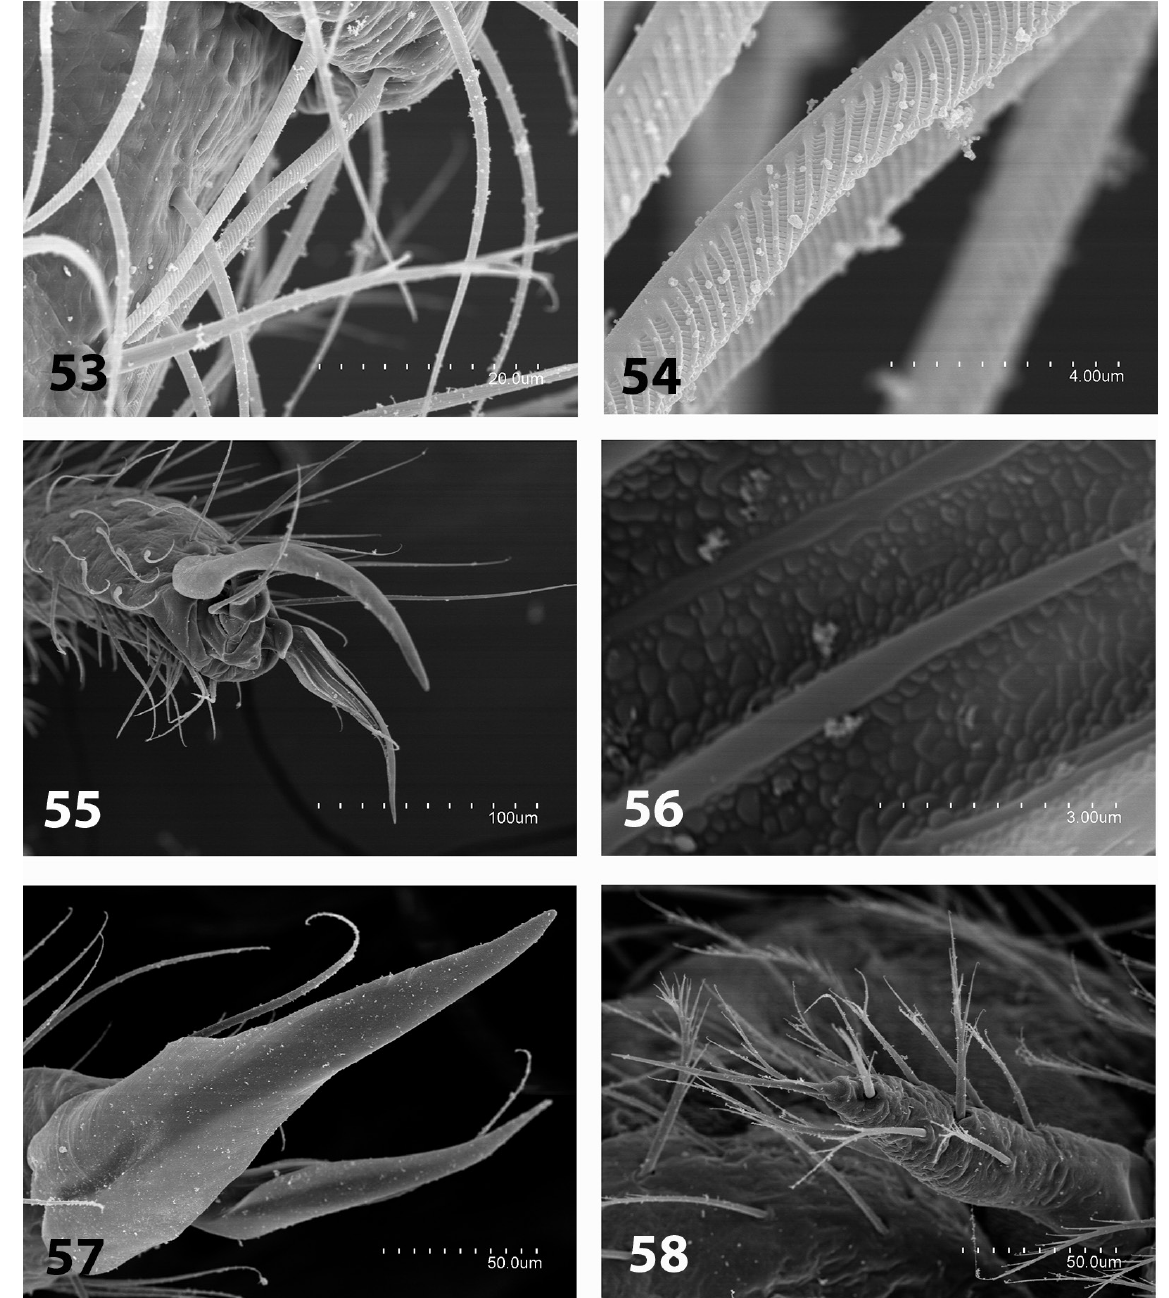
Figs 53–58. Plusiocampa ( Plusiocampa ) hoelzeli (Neuherz, 1984), from Renejevo brezno Cave, collected at a depth of 1180 meters, Kanin Mountains, Slovenia (Coll. AS). 53 . Lateral side of a middle antennomere with several gouge sensilla. 54 . Medial portion of several gouge sensilla, detail. 55 . Pretarsus, lateral posterior view. 56 . Ventral surface of anterior claw, detail. 57 . Pretarsus, with posterior claw in the foreground, dorsal view. 58 . Abdominal